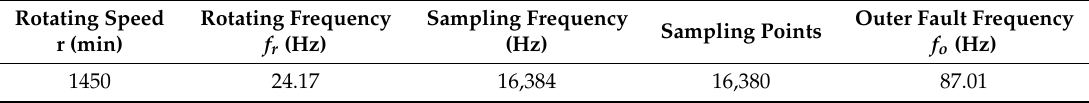
Table 4. Experimental parameters of rolling bearings.